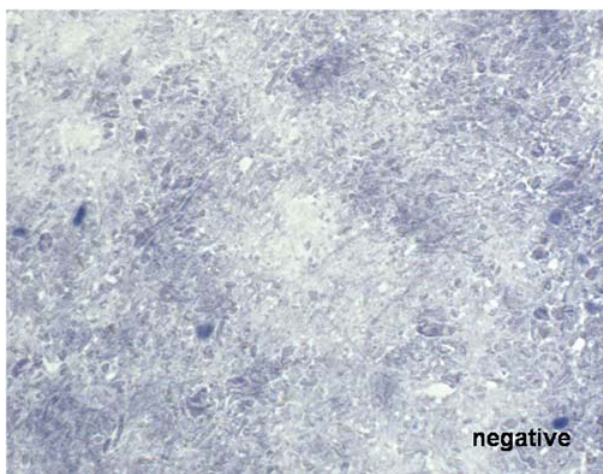
Figure 2. Picture of a negative result by the dRIT of a Chadian rabies sample, Magnification 400 6 .